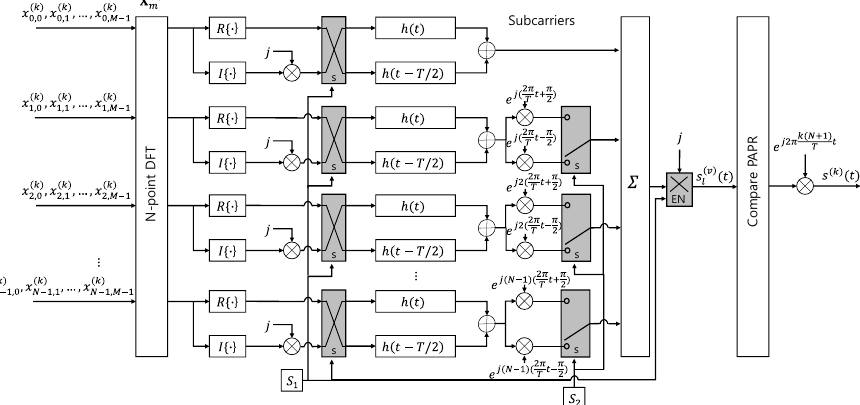
Figure 3. Structure of the the k -th user’s low peak-to-average power ratio filter bank multicarrier (LP-FBMC)